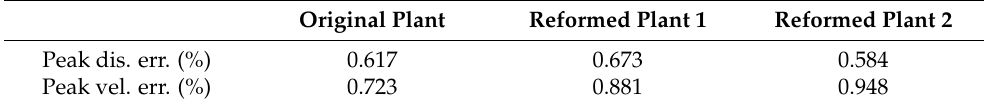
Table 1. Peak dis. and vel. err. of three control plants. Original Plant Reformed Plant 1 Reformed Plant 2 Peak dis. err. (%) 0.617 0.673 0.584 Peak vel. err. (%) 0.723 0.881